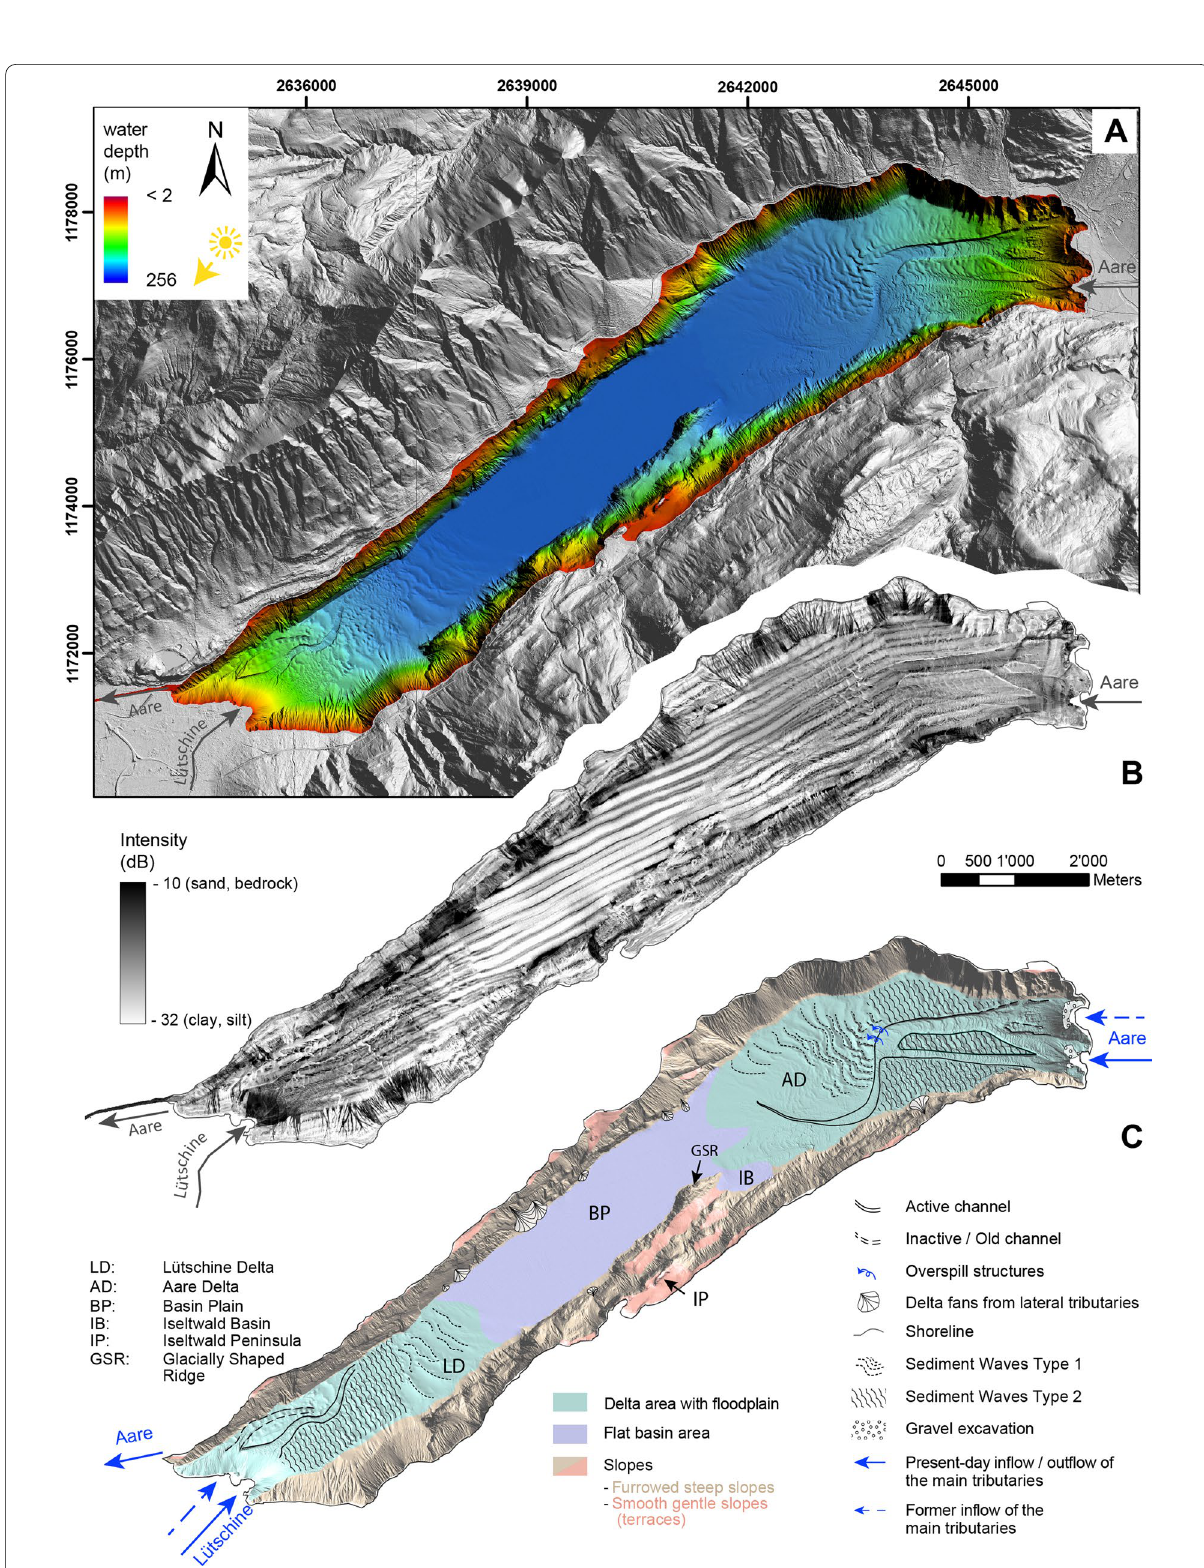
Fig. 2 A High-resolution bathymetric map of Lake Brienz (2 m grid size, shaded relief with colours representing depth) with shaded relief (swisstopo swissALTI3D digital elevation model) of the catchment. B Backscatter-intensity map revealing areas with coarse and hard material (high intensities). Note the basin-parallel data artefacts (dark stripes) which are swath bathymetry related. C Interpreted morphology of Lake